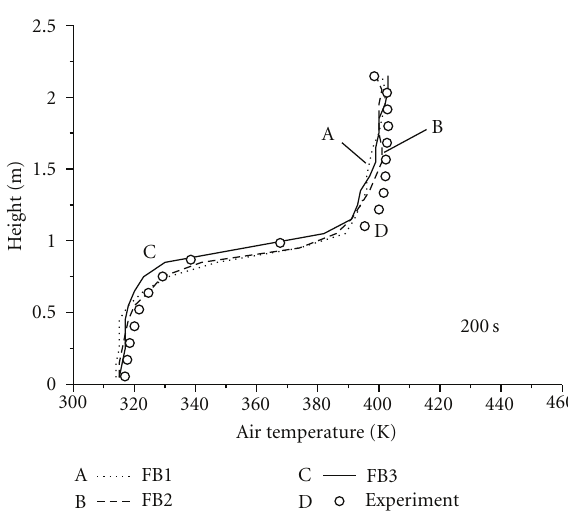
Figure 11: Air temperatures at 200s by thermocouple tree